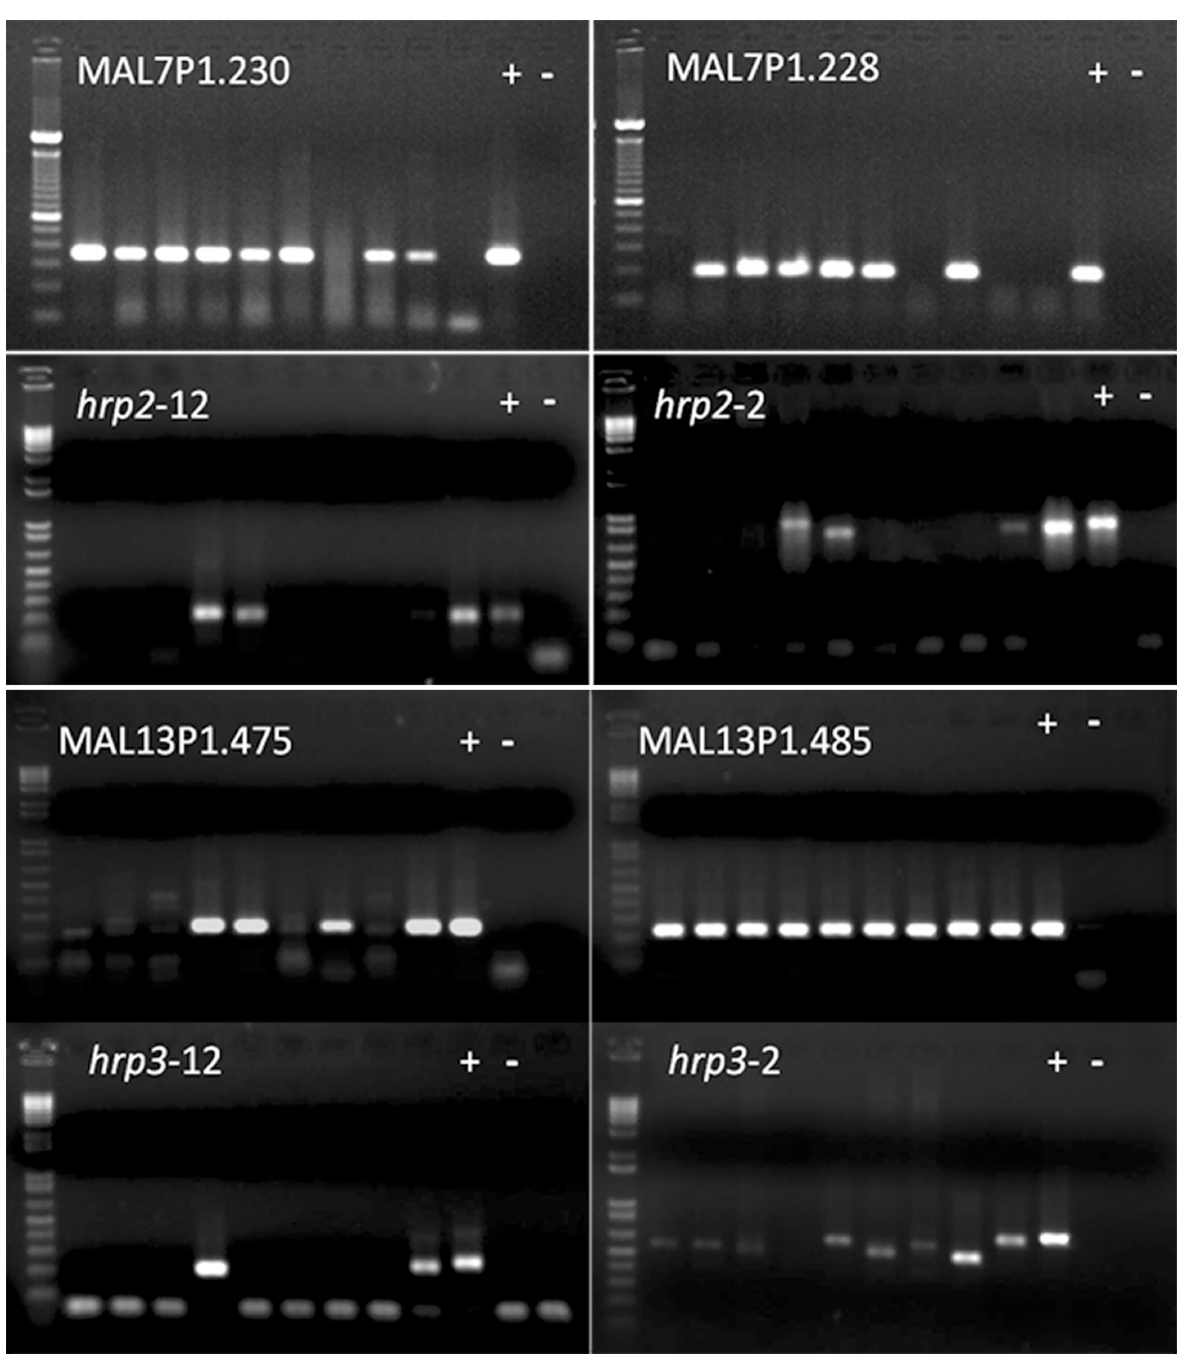
Fig 3. Molecular analysis of RDT negative P . falciparum samples. Nested PCR amplification of genes; Upstream (MAL7P1.230) and downstream (MAL7P1.228) flanking genes of pfhrp2 , pfhrp2 exon 1 – 2 ( hrp2-12 ), pfhrp2 exon2 ( hrp2-2 ), upstream (MAL13P1.475) and downstream (MAL13P1.485) flanking genes of pfhrp3 , pfhrp3 exon 1 – 2 ( hrp3-12 ), pfhrp3 exon2 ( hrp3-2 ). Each gel picture shows 100bp marker on 1 st well then amplified gene of samples with their positive and negative controls